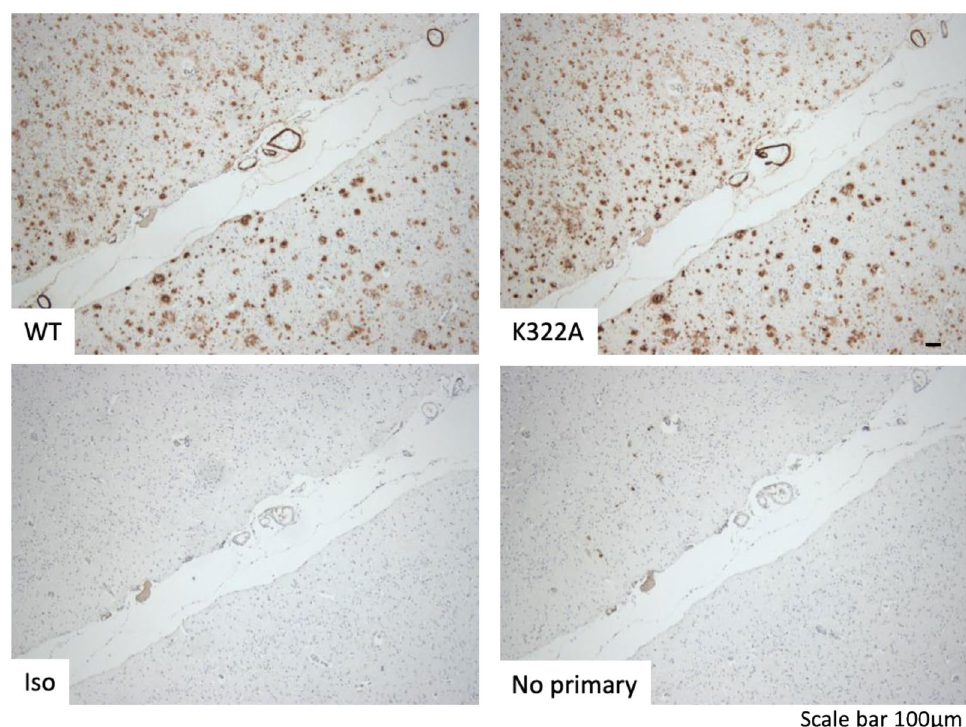
Figure 8. Detection of pE3-A β by PBD-C06 in human AD brain. Formalin-fixed (1 hour) and paraffin- embedded human AD parietal cortex sections were stained with two variants of PBD-C06. The humanized development candidate harboring the K322A mutation (K322A, top right) displayed identical staining of pE3-A β deposits as the parent antibody (WT, top left). Controls are provided by either using an isotype control primary human IgG1 antibody (Iso) or by omitting the primary antibody (No